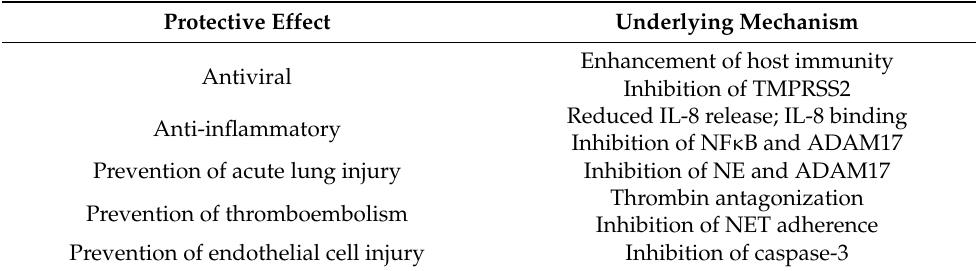
Table 2. Protective effects of augmentation therapy in SARS-CoV-2